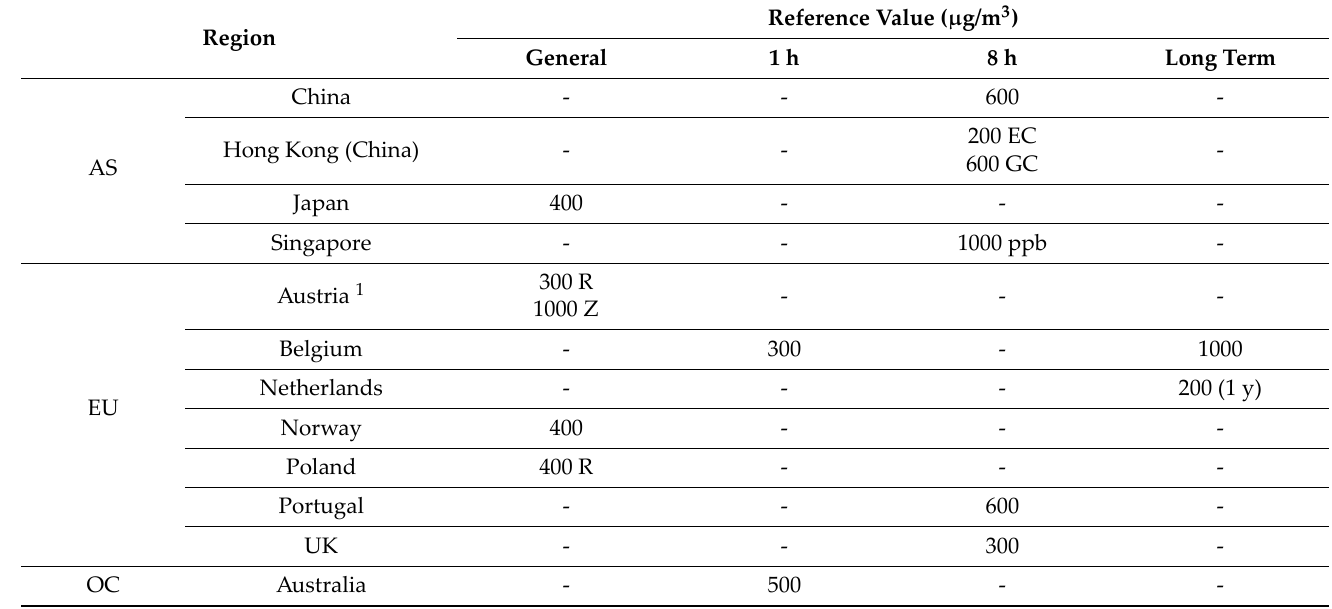
Table 20. Reference values for